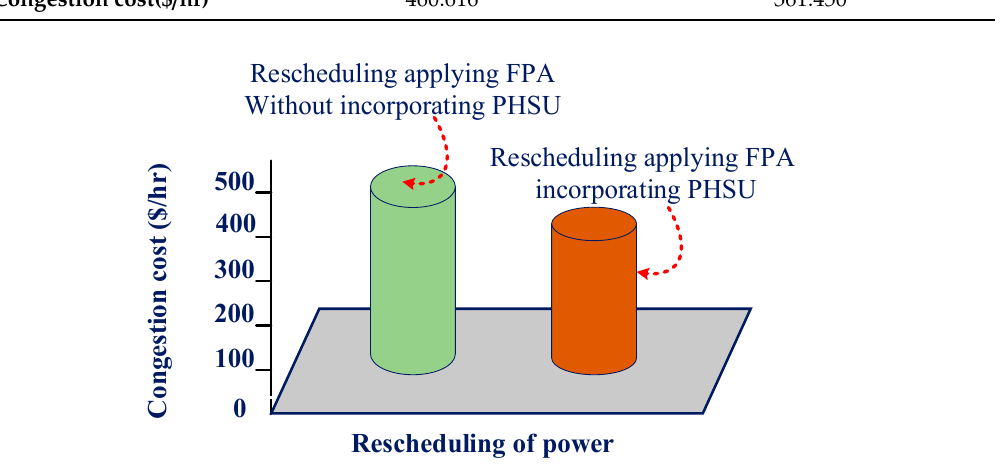
Figure 13. FPA-based cost comparison in placement of PHSU for managing congestion.